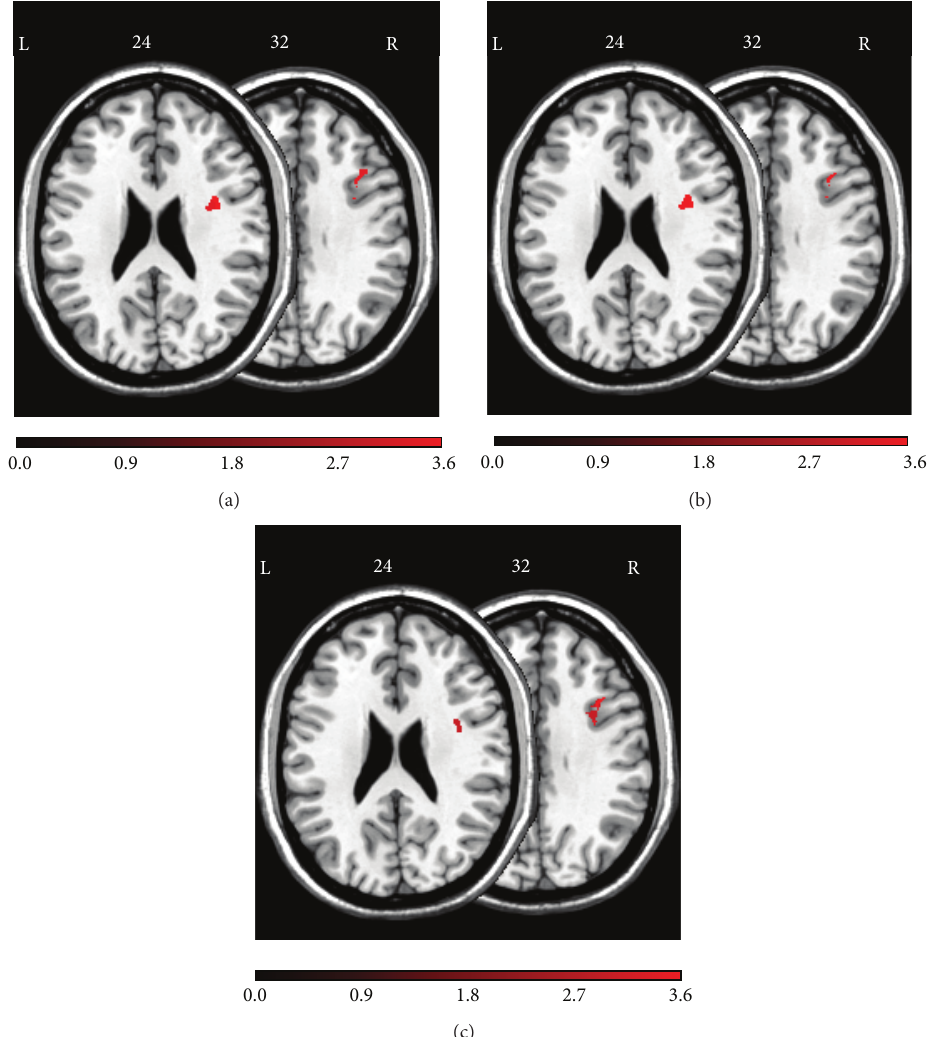
Figure 3: Anatomical results obtained from the voxel-based lesion-behavior mapping (a) on the number of TMT-B total errors, (b) on the number of TMT-B shifting errors (error type A + type B), and (c) on the number of TMT-B sequencing errors (error type C + type D). The location of voxels for which the voxel-based lesion-behavior mapping indicated that the observed Bz surpassed 𝑧 details. Numbers indicate MNI